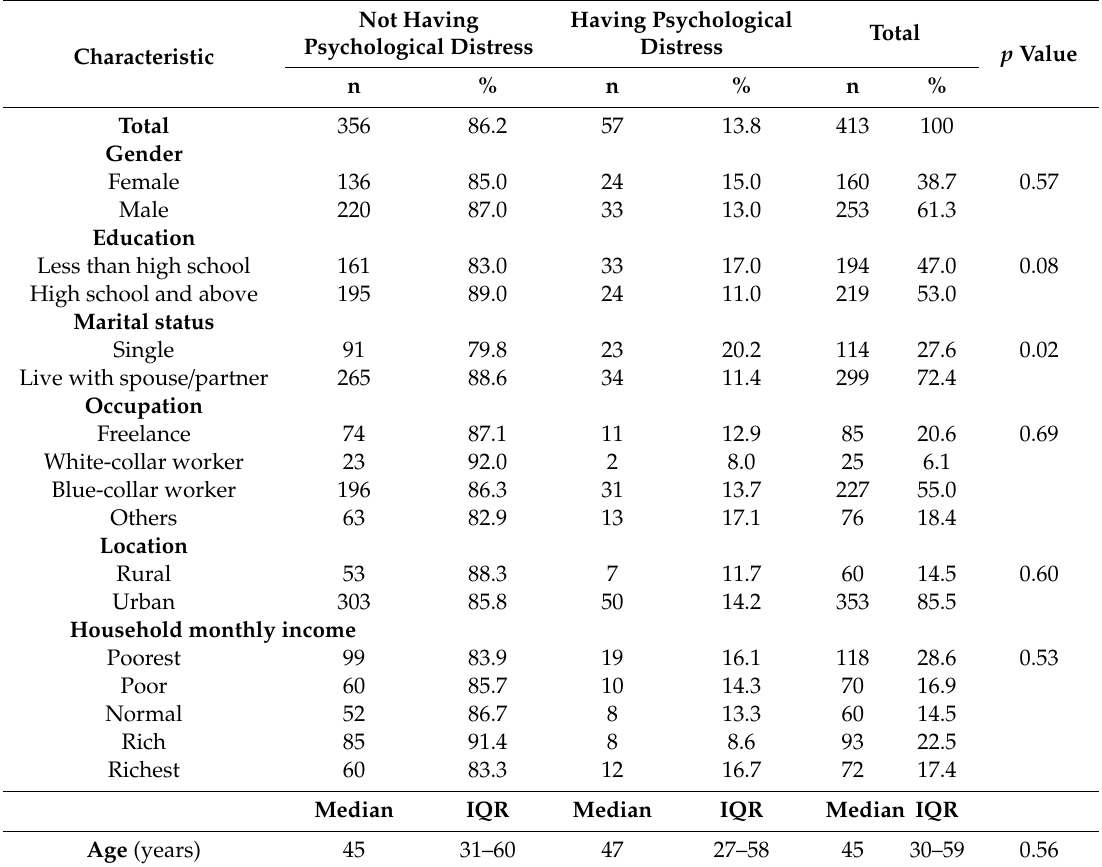
Table 1. Socioeconomic status of the